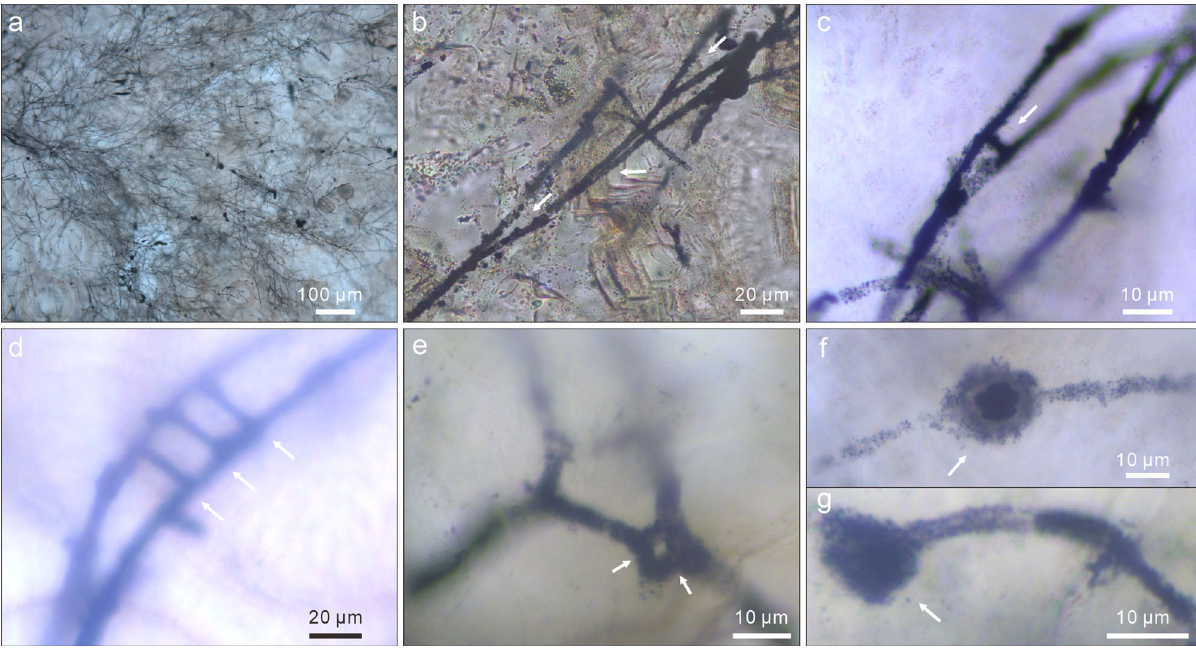
Fig. 3 TLM photomicrographs of Type B fi laments and associated small spheres. a Aggregate of Type B fi laments. b Multiple orders of branches (arrows). c A-like branching system (arrow). d , e Ladder-like or H-like branching systems (arrows). f Small intercalary sphere (arrow) coaxially aligned with a fi lament. g Small terminal sphere (arrow) attached to a fi